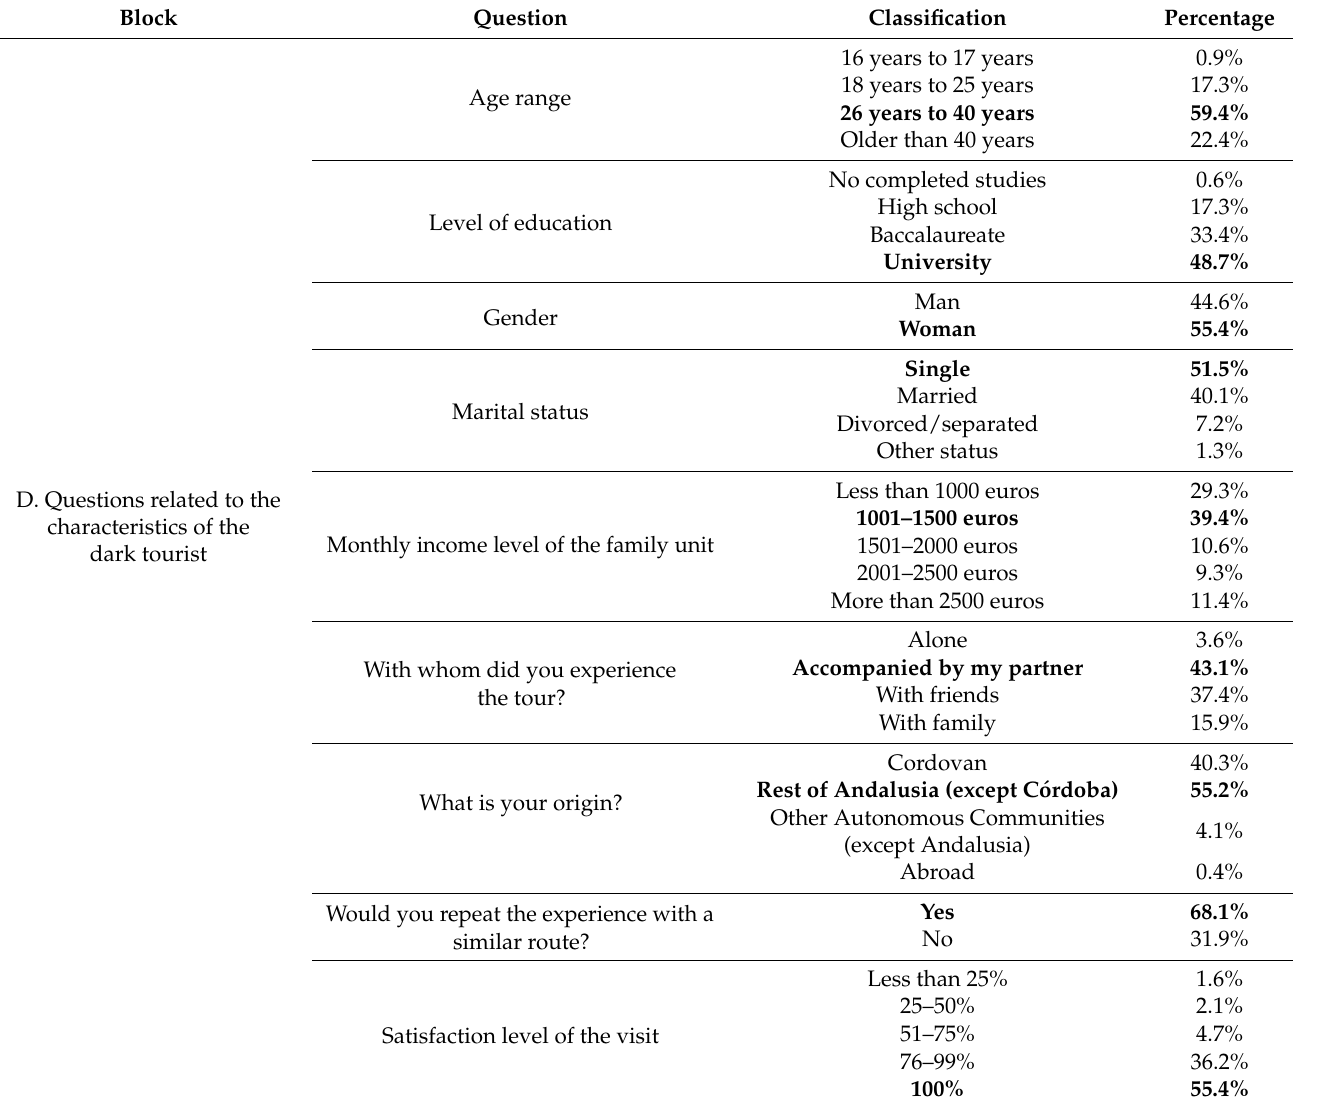
Table 2. Profile of the tourist of dark tourism of C ó rdoba and